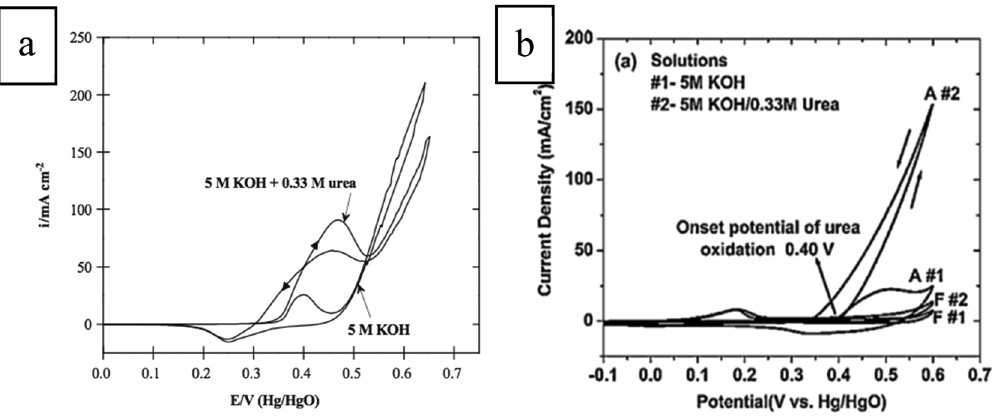
Figure 3: CVs of nickel nanoparticle electrode [ 1 ] ( a ) and Ni – Co hydroxide electrodes [ 35 ] ( b ) in 5 M KOH in the presence and absence of urea, republished with